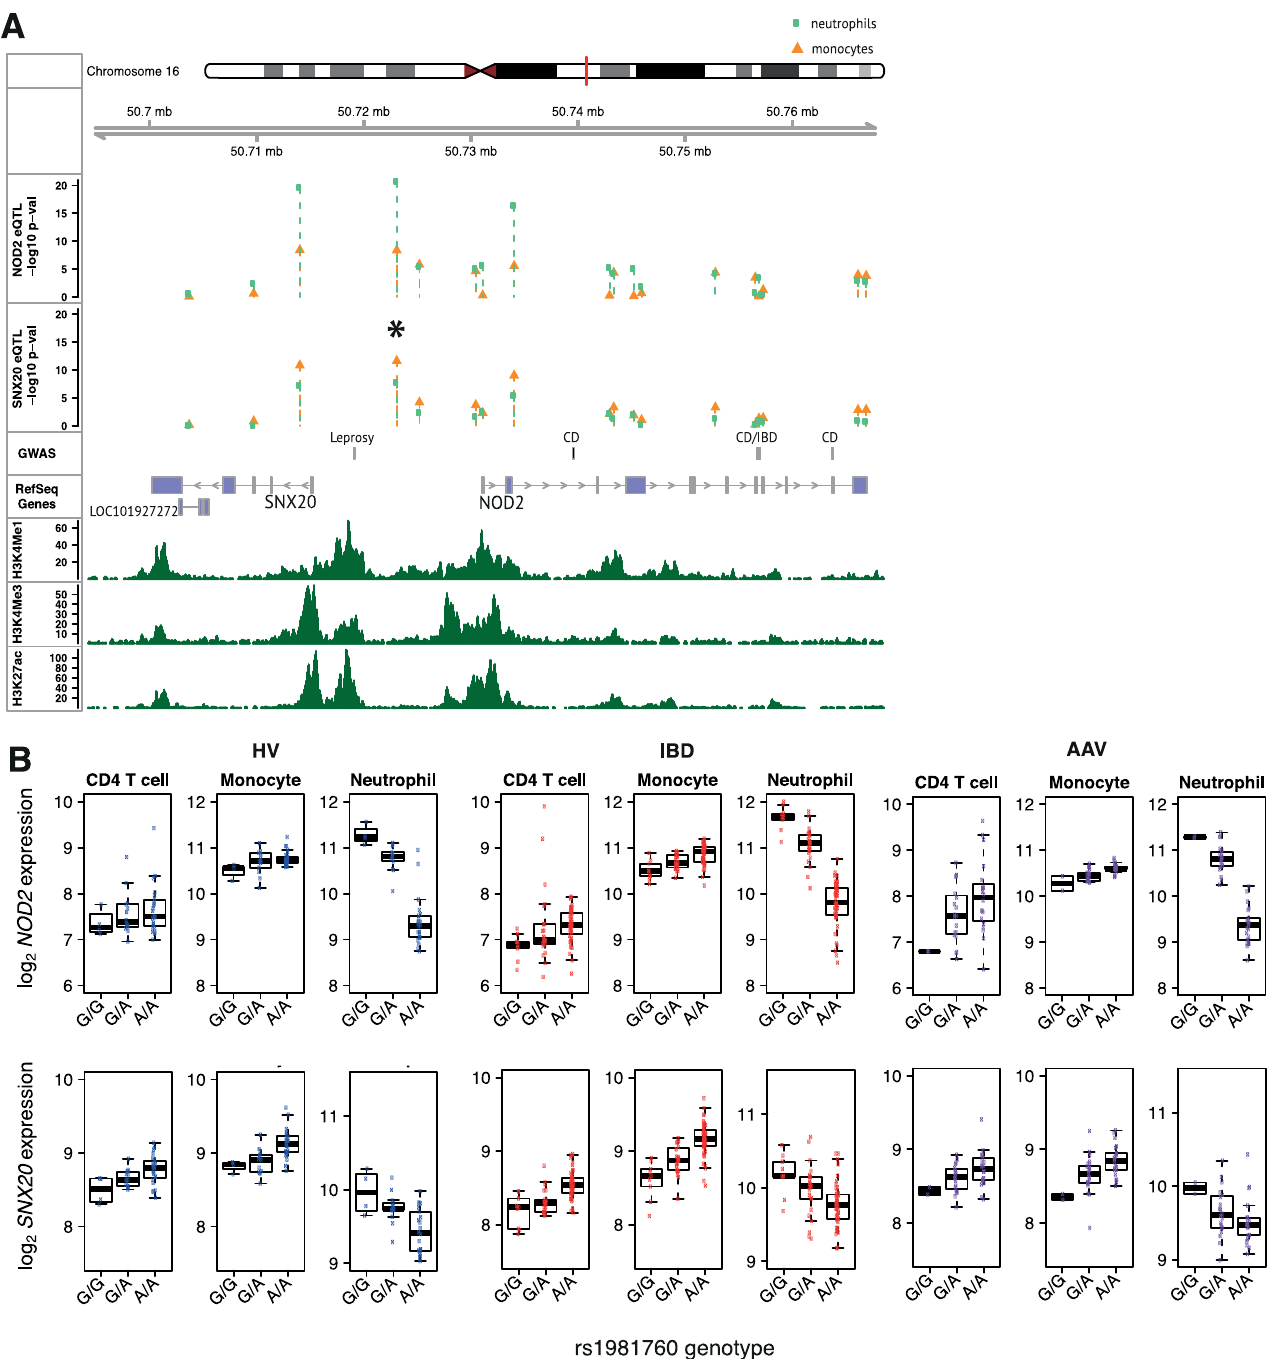
Fig 8. Multiple cell-type eQTL analysis and the genetic aetiology of autoimmune and infectious diseases. An eQTL for both NOD2 and SNX20 , with opposing directions of effect in neutrophils versus CD4 T cells and monocytes, at a leprosy-associated locus ( r 2 0.922 between eSNP rs1981760 ( * ) and leprosy-associated SNP rs9302752). (A) Genomic features in the SNX20 - NOD2 region. Tracks from top: 1) Chromosome ideogram. Red line indicates the position of the region. 2) Chromosomal position. 3 – 4) Manhattan plots of association signals for NOD2 and SNX20 expression in monocytes and neutrophils (IBD-HV analysis). 5) Disease associated SNPs from the NHGRI GWAS catalogue. 6) RefSeq genes. 7 – 9) Histone marks from ENCODE. (B) Expression versus genotype boxplots.